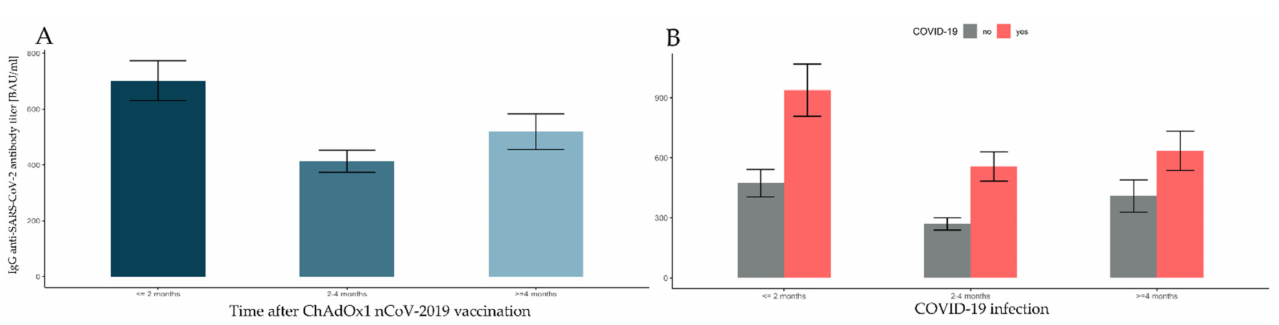
Figure 6. Comparisons of antibody levels following full vaccination with ChAdOx1 nCoV-2019, taking into account the time factor and the incidence of SARS-CoV-2 infection. The error bars for marginal means with 95% confidence intervals (bootstrapped) are presented in turn: ( A ) the time elapsed after the full ChAdOx1 nCoV-2019 vaccination; ( B ) prior COVID-19 infection grouped with different time intervals elapsed after full ChAdOx1 nCoV-2019